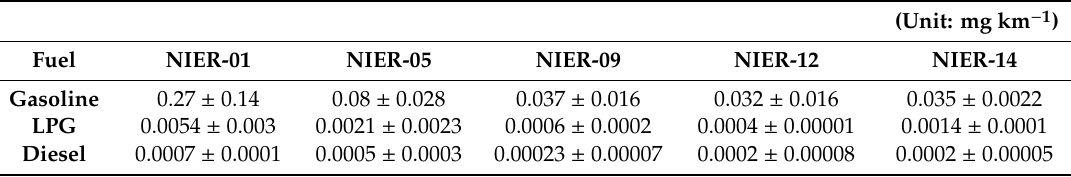
Table 2. BC emission from di ff erent types of fuels; gasoline indicates GDI vehicles applied PM regulation (0.004 g km − 1 ), LPG vehicles and diesel in EURO 6 vehicle at various speeds in the NIER mode.